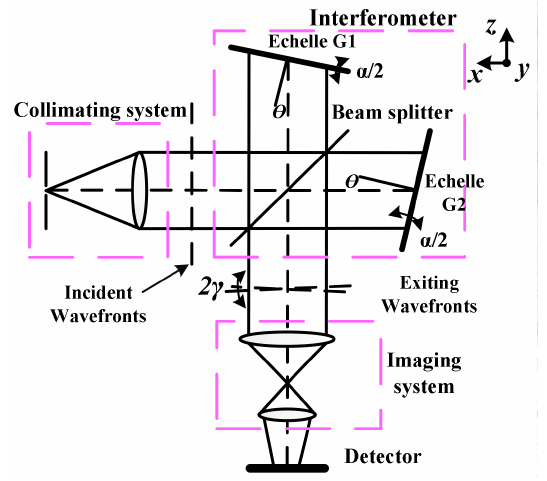
Figure 1. Structure diagram of 2D spatial heterodyne spectrometer